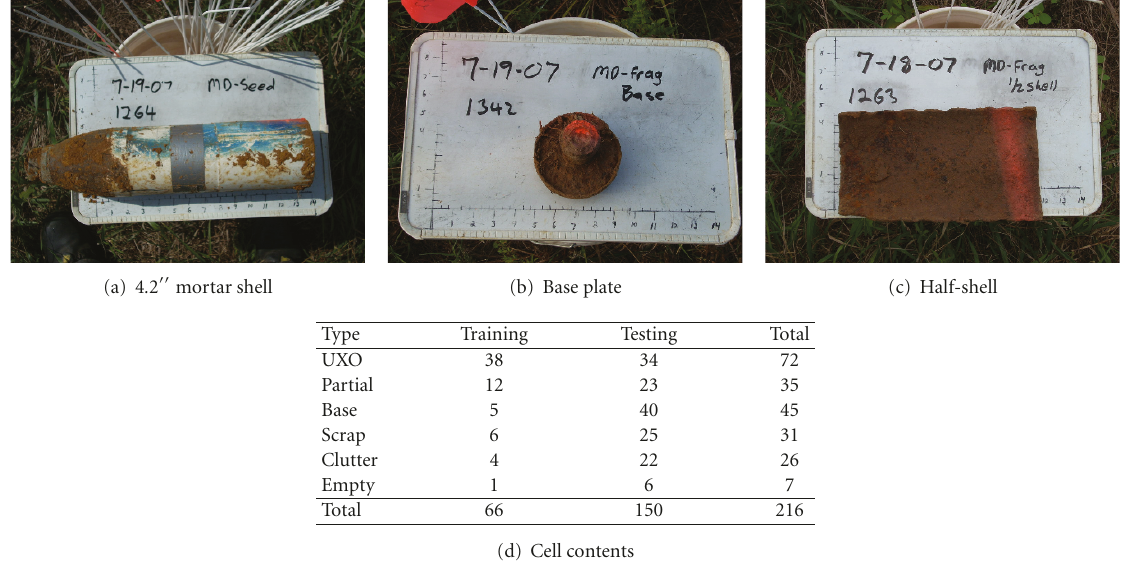
Figure 1: Representative examples and relative populations of the objects buried at the Camp Sibert